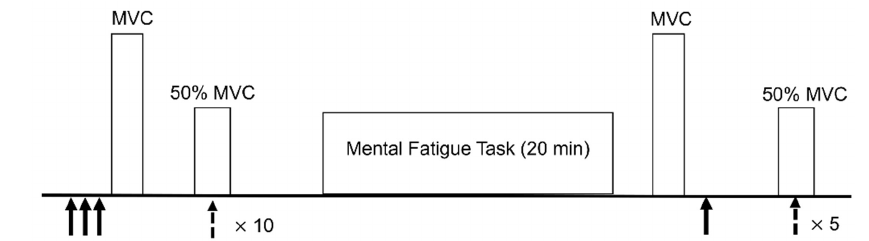
Figure 1. Overview of experimental timeline. Black solid arrow: electrical stimulation. Black dashed arrow: transcranial magnetic stimulation. Subjective ratings of fatigue were provided before and after the protocol.